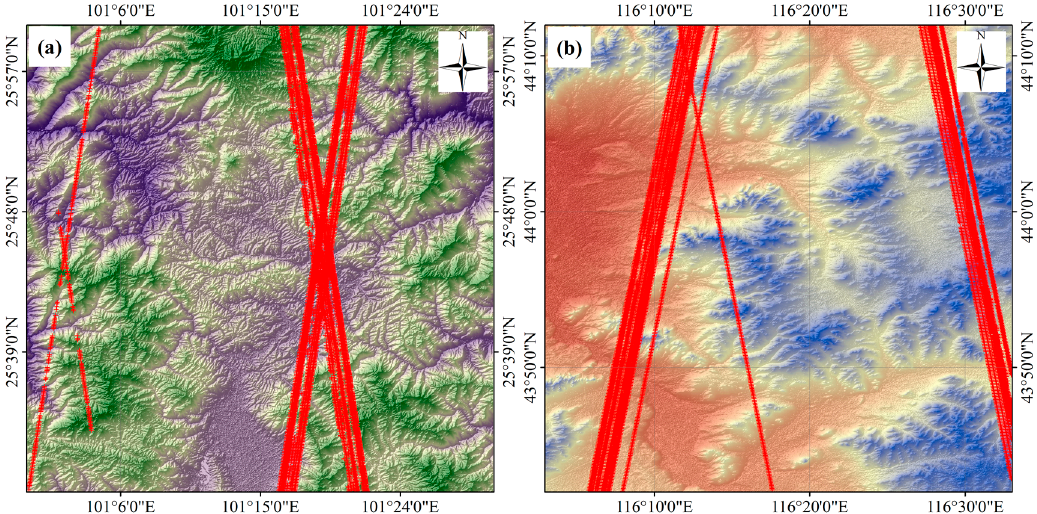
Figure 2. Distribution of the GLAH14 points (red) in ( a ) the mountainous site, and ( b ) the low-relief site.